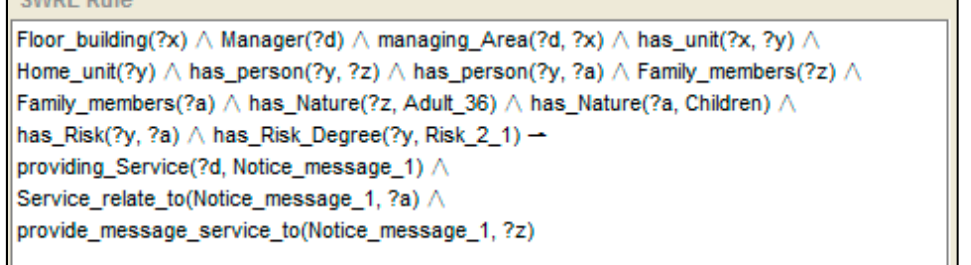
Figure 14. An example of service provision expressed by the SWRL rule.